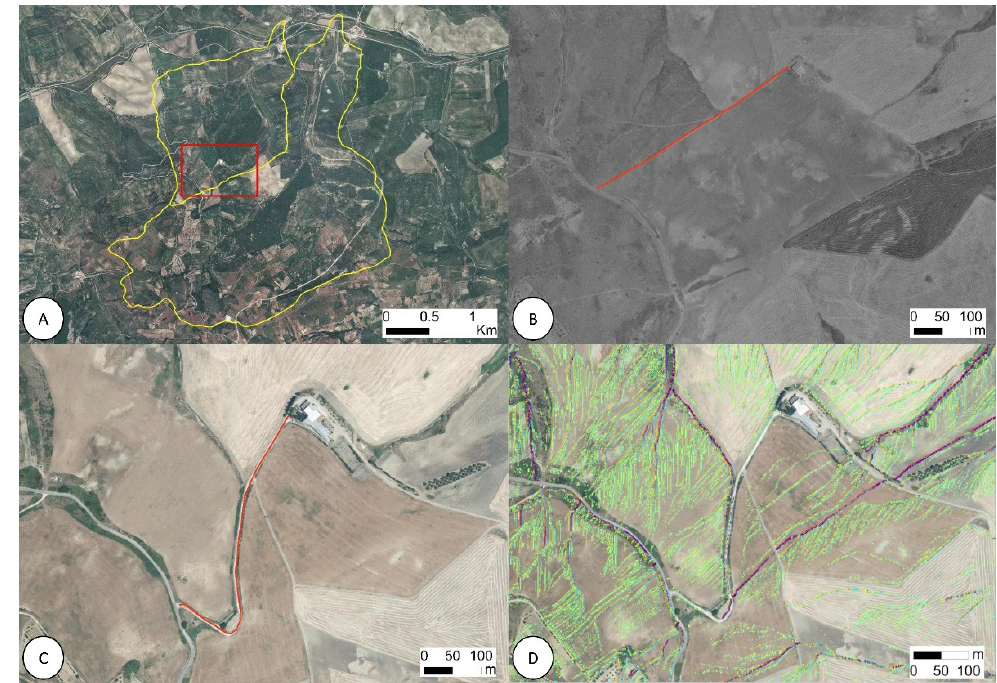
Figure 10. Road position change ( A ): location map showing the catchment area (yellow line) and the hazelnut crop area (red box). Orthophotos of 1974 ( B ), 2013 ( C ), and the USPED model ( D ). Note the changes of the road location (indicated by the red line).